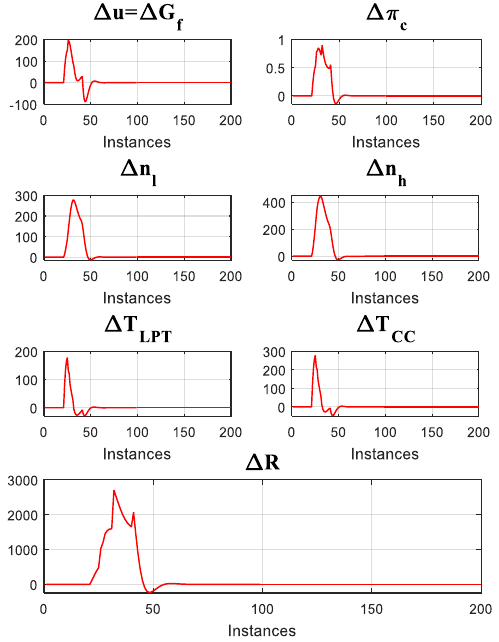
Figure 4. Simulation of dynamic deviations. (linear dynamic model within the hybrid